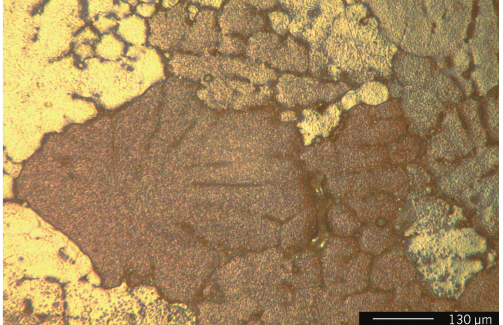
Figure 3: OM micrograph showing the microstructure of the nondeformed ( 𝑁 = 0 )